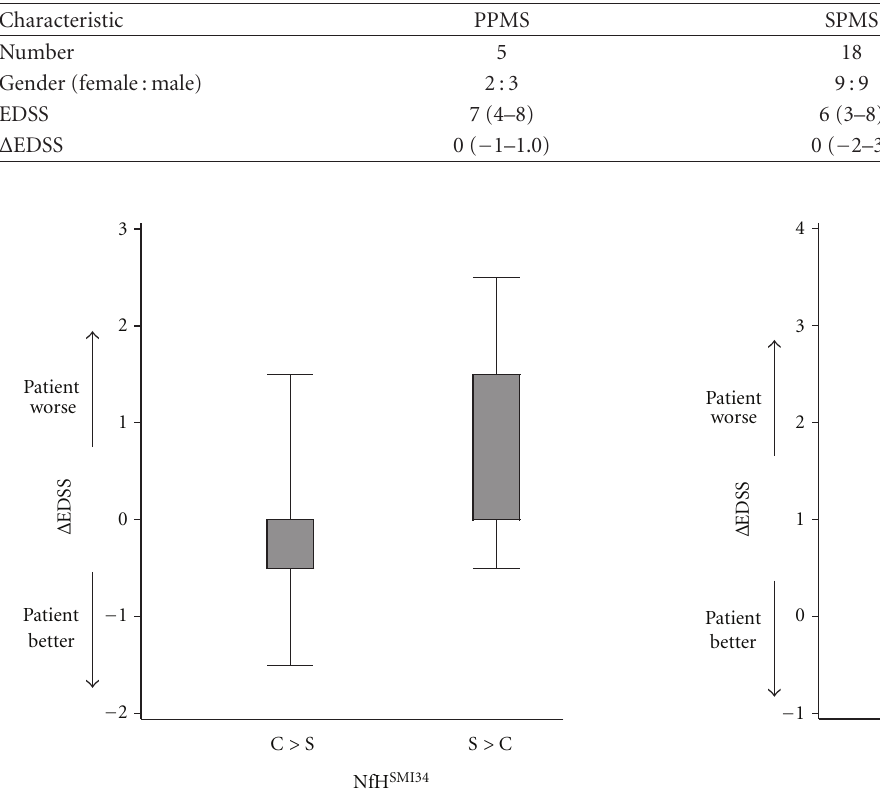
Figure 1: Disability progression in patients with RRMS is associ- ated with higher CSF NfH SMI35 levels compared to the correspond- ing serum concentrations ( P = . 0298) likely indicating neuroaxonal degeneration of the central nervous system. The median (thick horizontal bar), IQR (boxes), and range (whiskers) are shown.